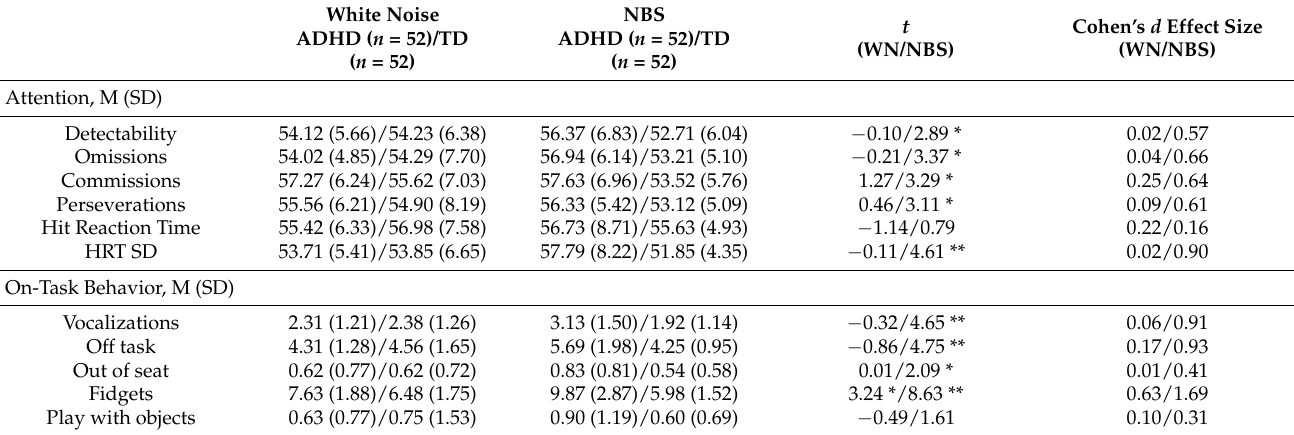
Table 2. Comparison of intrinsic and extrinsic performance between ADHD and TD